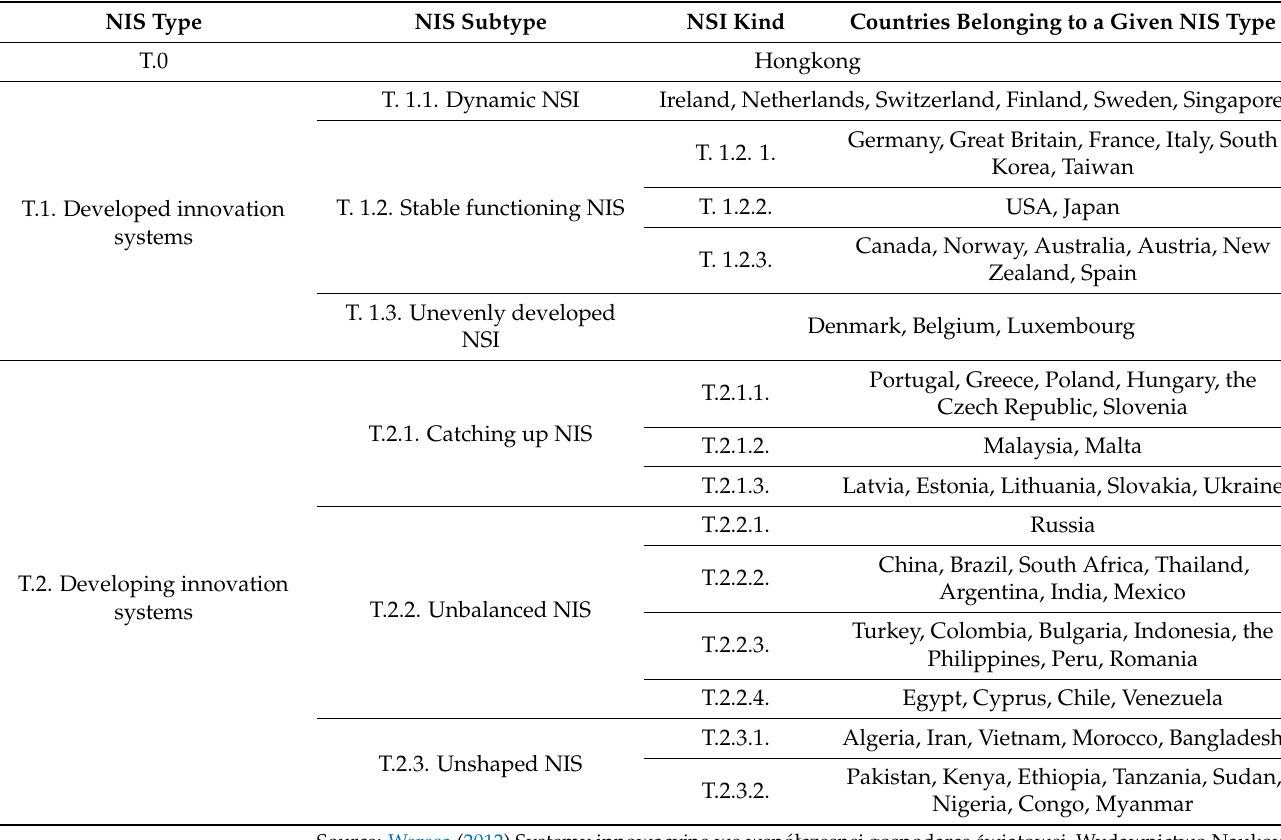
Table 2. Typology of national innovation systems according to M.M. Godinho, S. Mendonça, T.S. Pereira (GMP